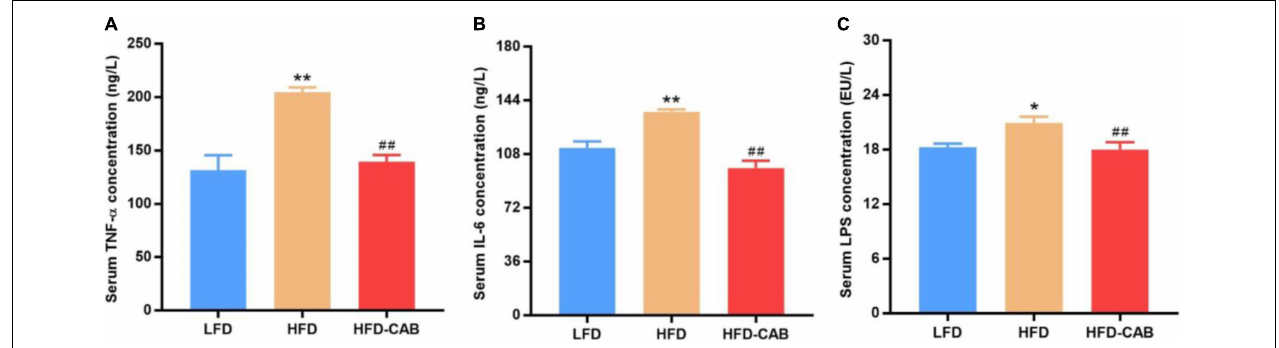
FIGURE 4 | Cooked adzuki bean ameliorates inflammation and metabolic endotoxemia in HFD-fed mice. (A) Serum tumor necrosis factor- α (TNF- α ) concentrations, (B) Serum interleukin-6 (IL-6) concentrations, and (C) Serum lipopolysaccharide (LPS) levels. Data presented as mean ± SEM, n = 7 per group. * P < 0.05 and ** P < 0.01 vs. LFD; ## P < 0.01 vs. HFD. LFD, low-fat diet; HFD, high-fat diet; HFD-CAB, high-fat diet supplemented with cooked adzuki